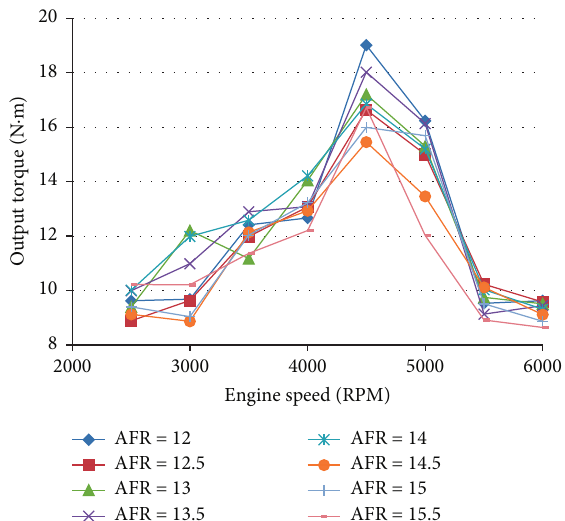
Figure 14: Power efficiency at different engine speeds.